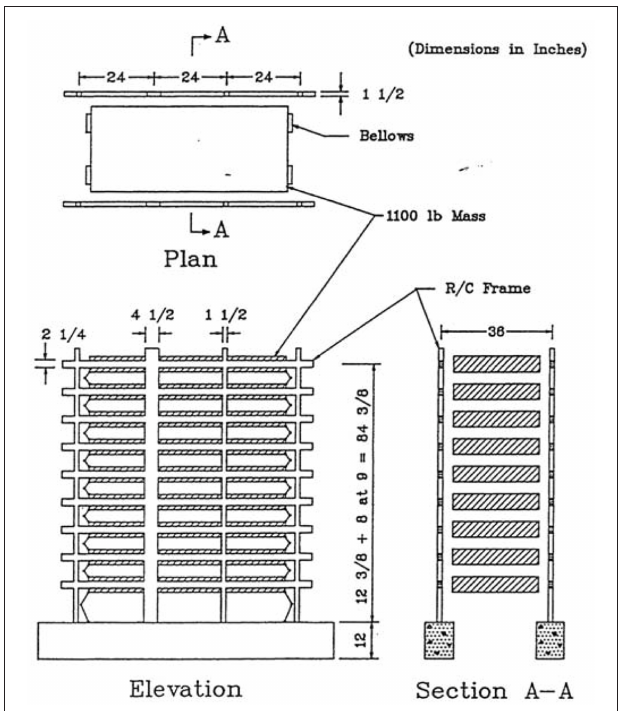
FIGURE 10 | Dimensions of the Eberhard test specimen (Eberhard and Sozen, 1989 ).